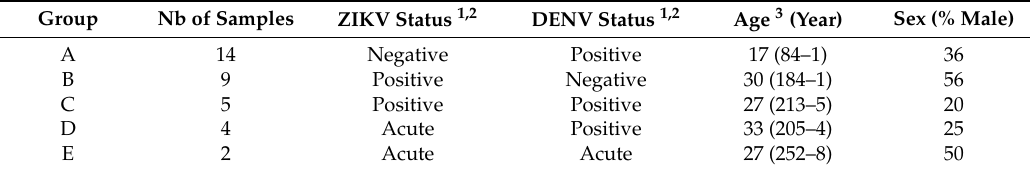
Table 1. Categories of donors in the study